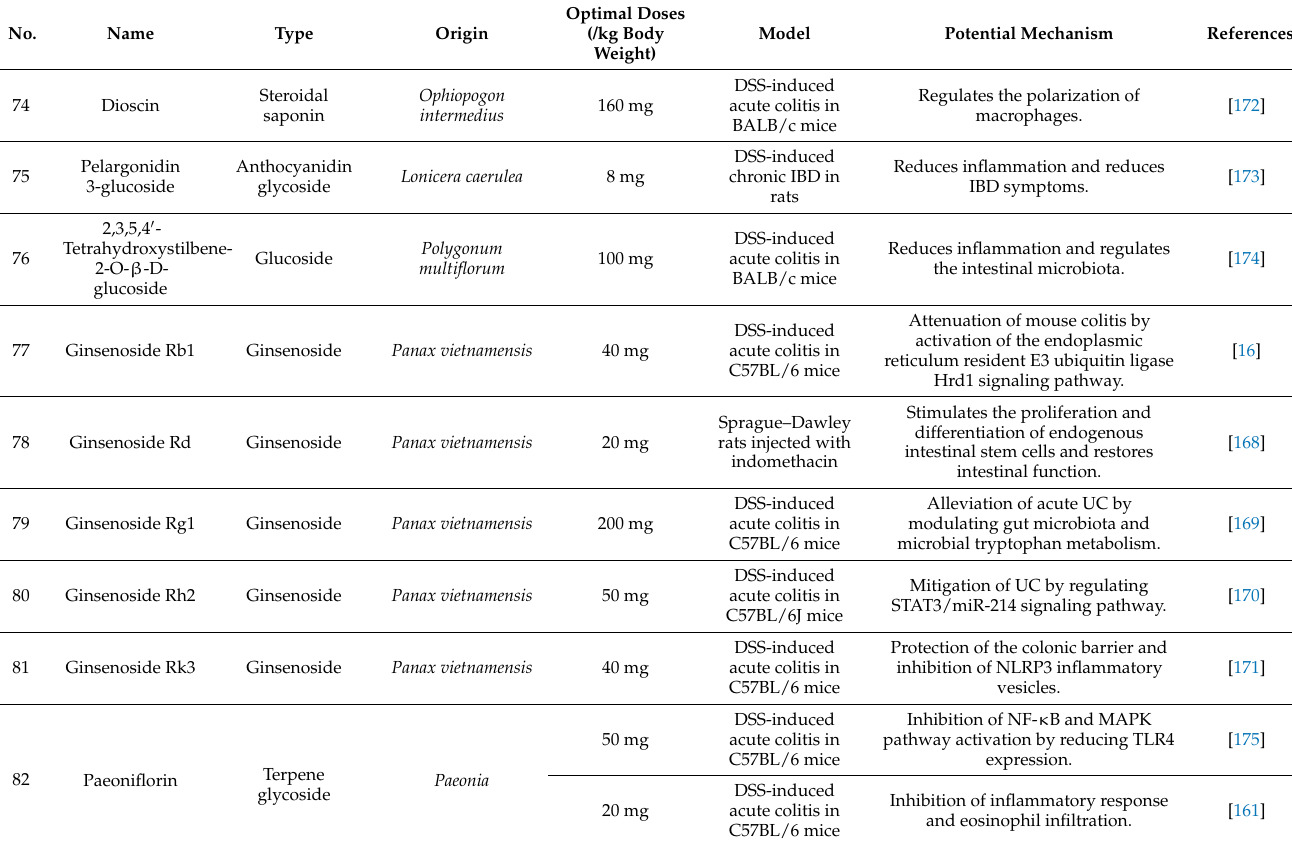
Table 3. In vivo therapeutic effects of glycosides on experimental